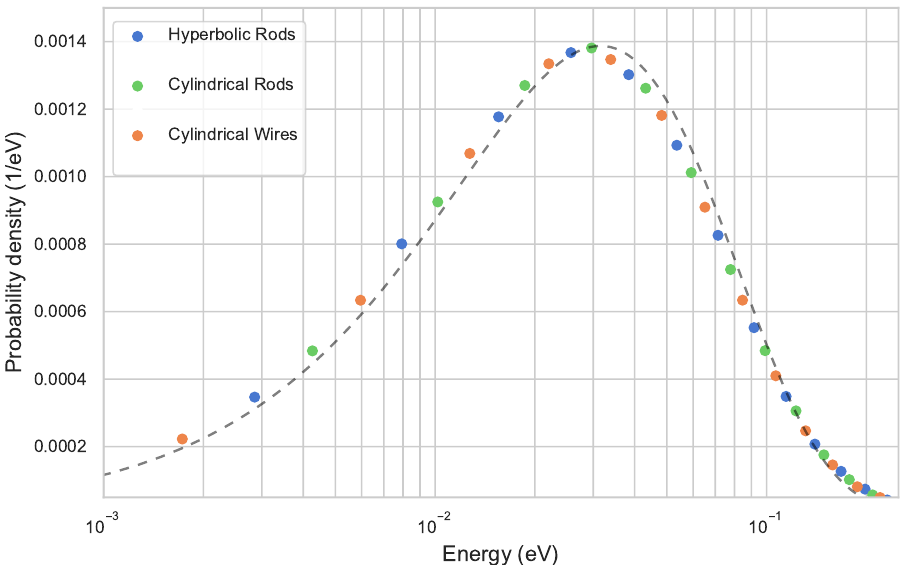
Figure 4. Simulated energy distribution of ions after collisions with helium buffer gas at 293 K for different trap configurations are shown. For traps with hyperbolic rods, cylindrical rods, and wires, the temperature obtained from the distributions are all 366 K, using Equation (3). On comparison with an analytical Maxwell–Boltzmann distribution at 366 K (black dashed line), it can be seen that the distribution is not perfectly